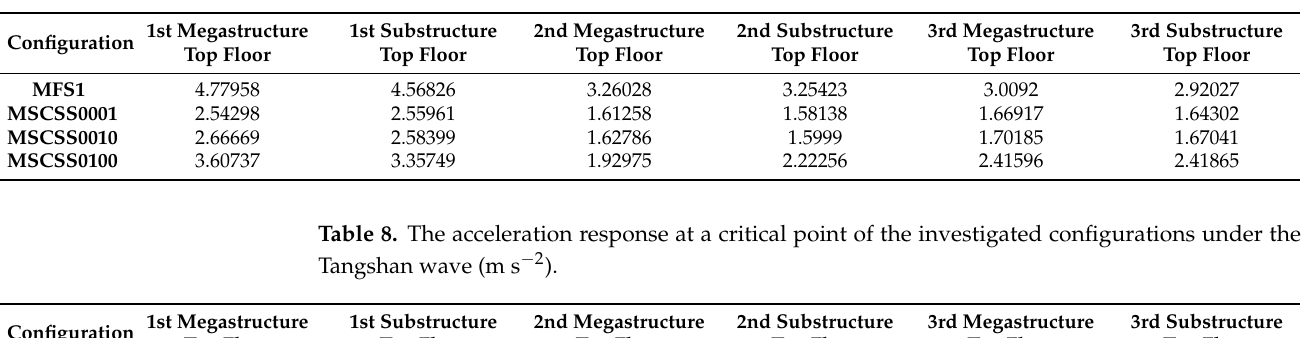
Table 7. The acceleration response at a critical point of the investigated configurations under the El Centro wave (m s − 2 ).